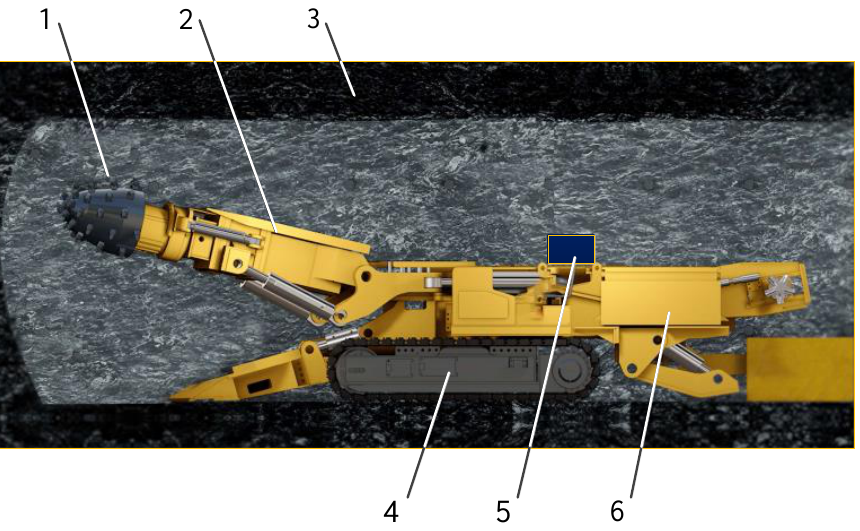
Figure 1. Schematic diagram for the roadheader (1-cutting head; 2-cutting arm; 3- coal wall; 4- walking mechanism; 5- SINS; 6- fuselage).